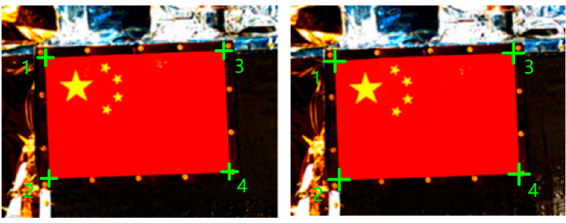
Figure 20. Extracted corner points of the national flag. Table 9. Verification of the dimensions of the flag on the lander.